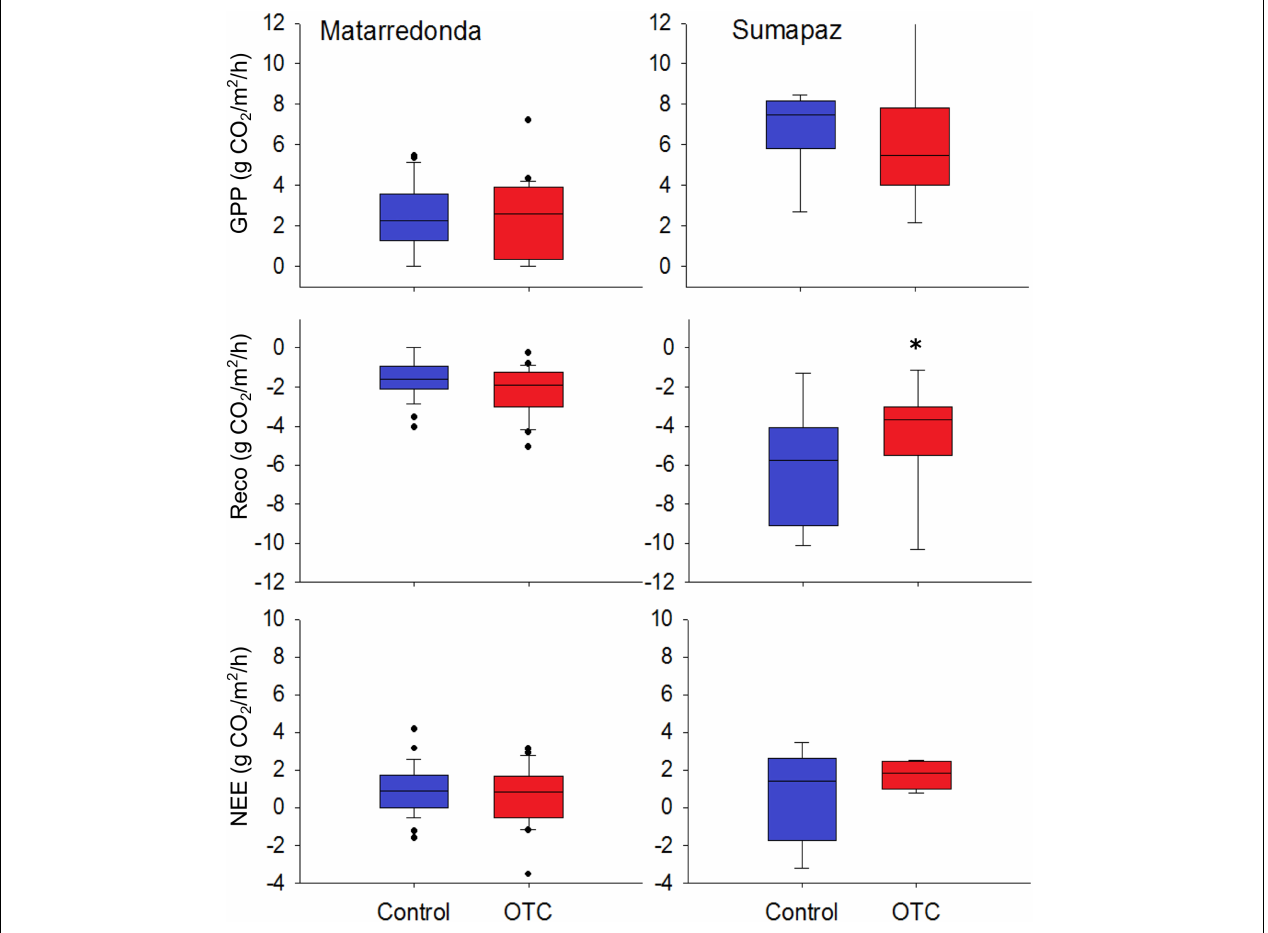
FIGURE 5 | Gross primary production (GPP), autotrophic and heterotrophic respiration (Reco), and net ecosystem exchange (NEE) measured inside the OTC and in the control plots after 3 years of warming. All box plots show the median, 25/75th percentiles within the box, 10/90th percentiles shown within the whiskers and the outlier. Asterisk denote statistically significant differences between OTC and control plots at P <